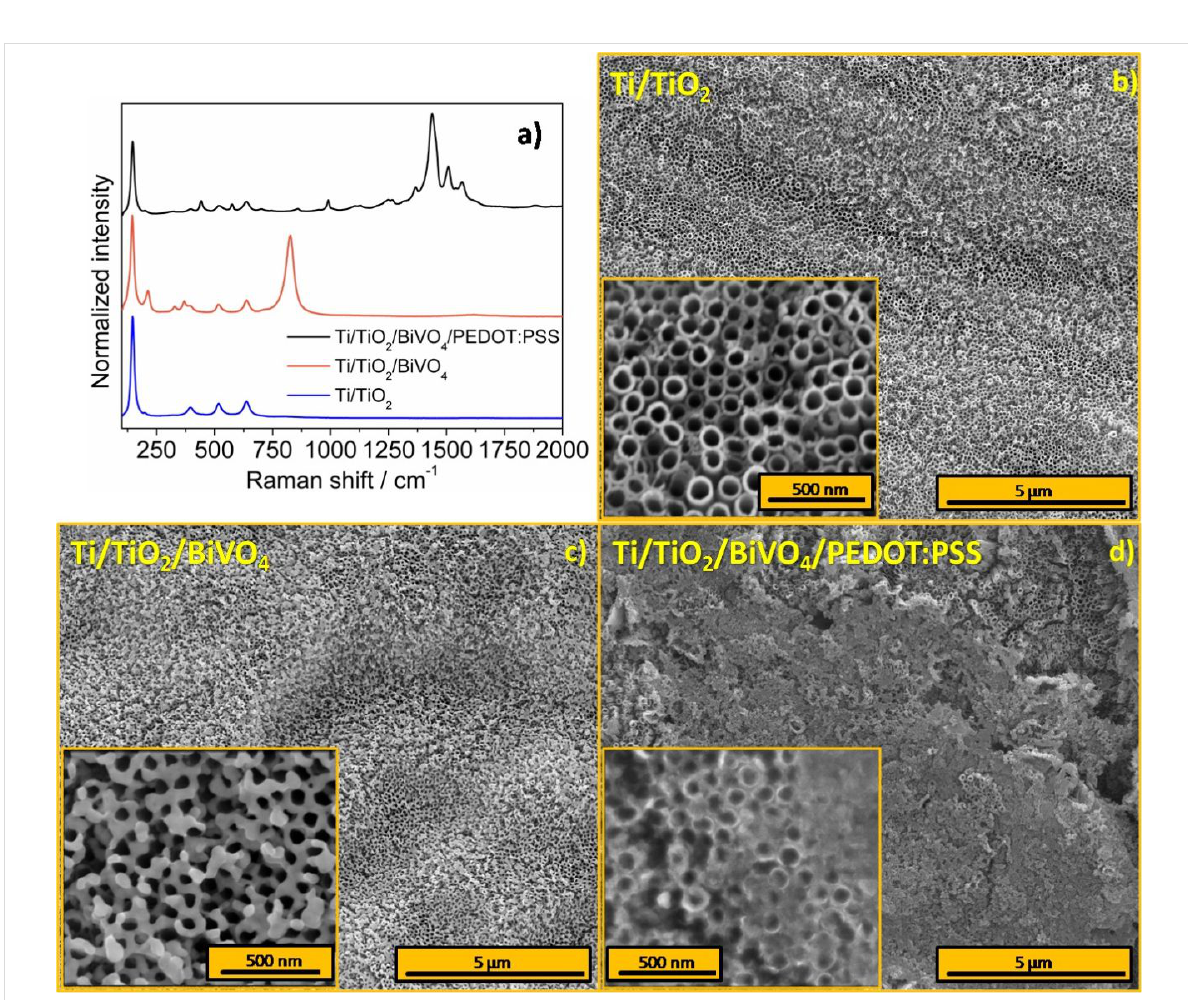
Figure 2: a) Raman spectra of Ti/TiO 2 (blue), Ti/TiO 2 /BiVO 4 (red), and Ti/TiO 2 /BiVO 4 /PEDOT:PSS (black). SEM micrographs of b) Ti/TiO 2 , c) Ti/TiO 2 /BiVO 4 , and d) Ti/TiO 2 /BiVO 4 /PEDOT:PSS. Insets in Figure 2b and 2c reprinted with permission from [26], copyright 2016